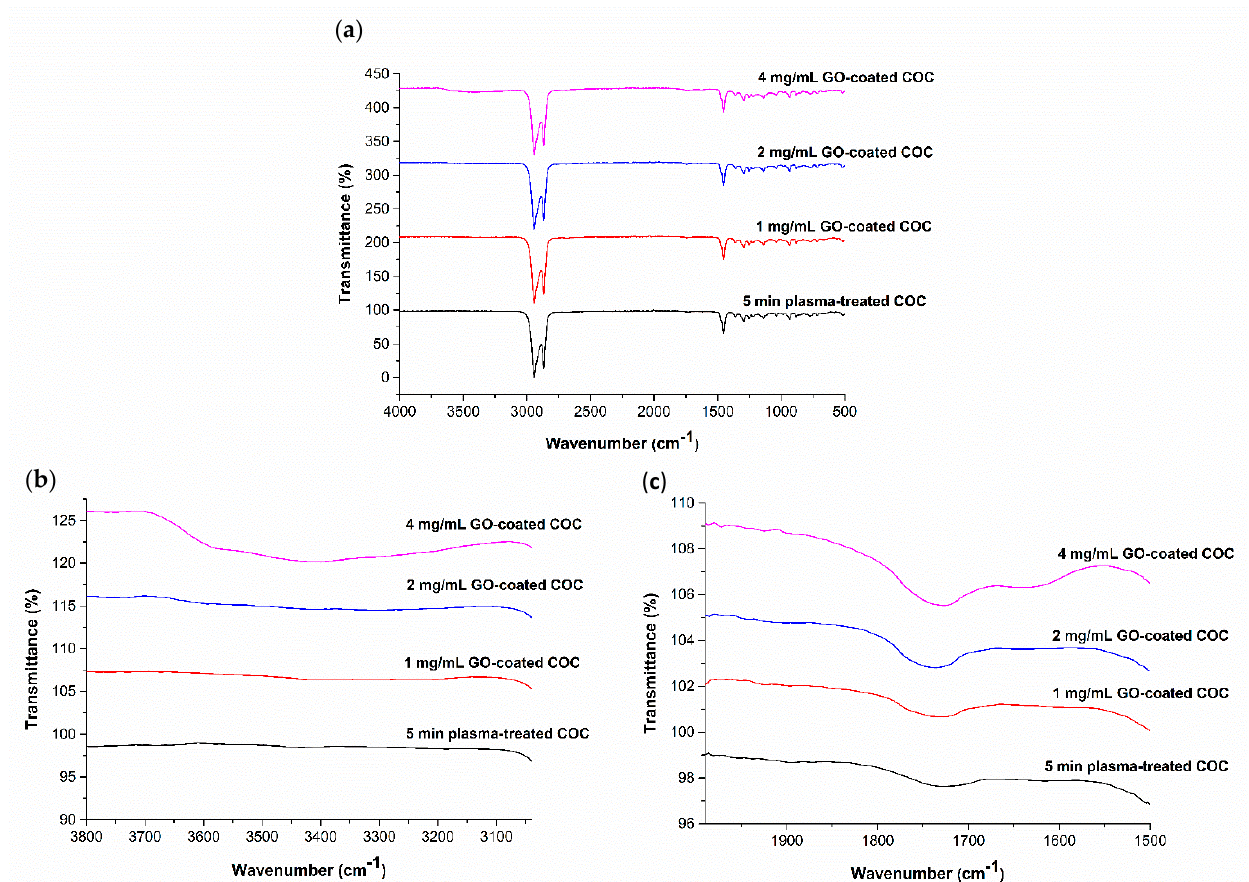
Figure 10. ( a ) FTIR − ATR spectra for five min plasma treated COC and subsequently GO − coated; Expanded regions of FTIR-ATR spectra between ( b ) 3050 − 3800 cm − 1 and ( c ) 1500 − 2000 cm − 1 .